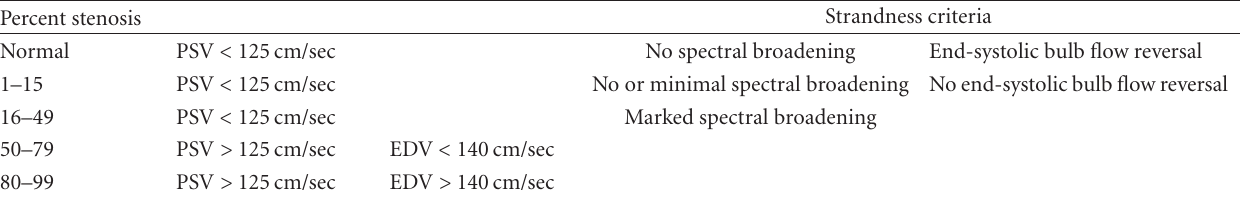
Figure 4: Right carotid stenosis demonstrated on Duplex US (Case 2) (a). Color image of the stenosis (b) and spectral US evaluation with PSV measure (c). According to the Strandness criteria, a stenosis of 50–79% was evaluated. Table 1: Hemodynamic parameters described by Strandness [15] for duplex assesment of internal carotid artery